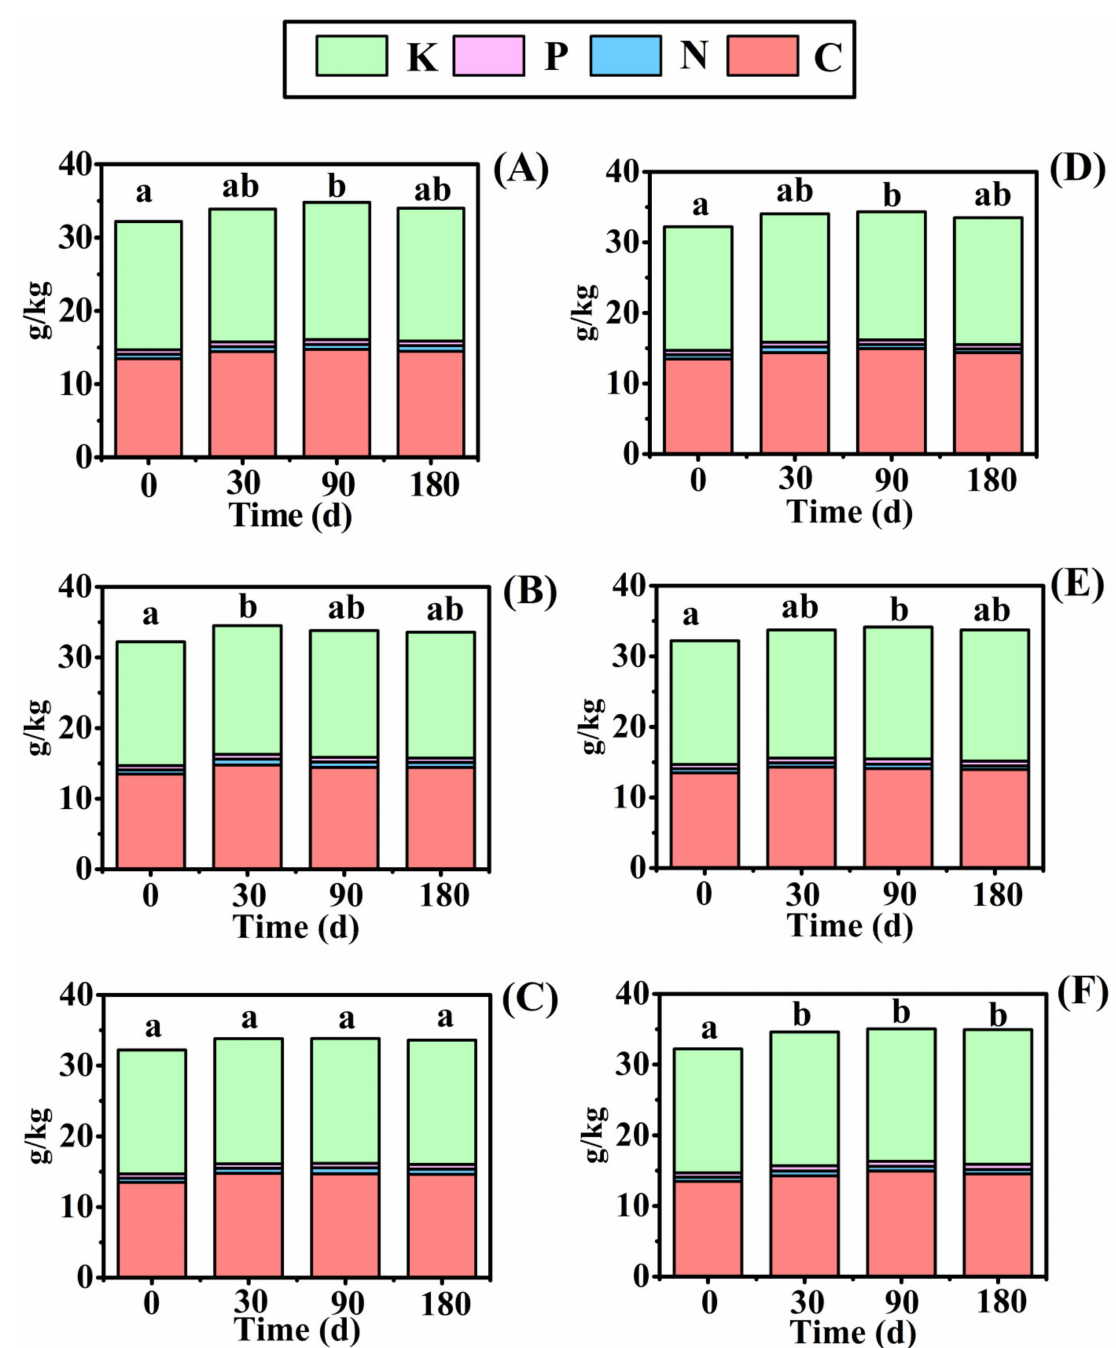
Figure 5. Total soil carbon, nitrogen, phosphorus, and potassium concentration of E. crusgali and B. tripartita litter decomposition after 0, 30, 90, 180 days at 0, 5, 10 cm burial depths under flooding. ( A ) E. crusgali at 0 cm; ( B ) E. crusgali at 5 cm; ( C ) E. crusgali at 10 cm; ( D ) B. tripartita at 0 cm; ( E ) B. tripartita at 5 cm; ( F ) B. tripartita at 10 cm. Different letters denote a significant difference in total soil nutrients among given dates ( p <